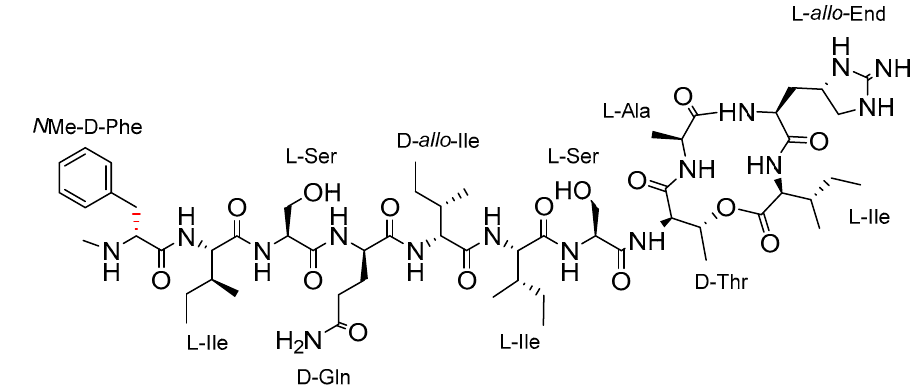
Figure 1. Chemical structure of teixobactin.